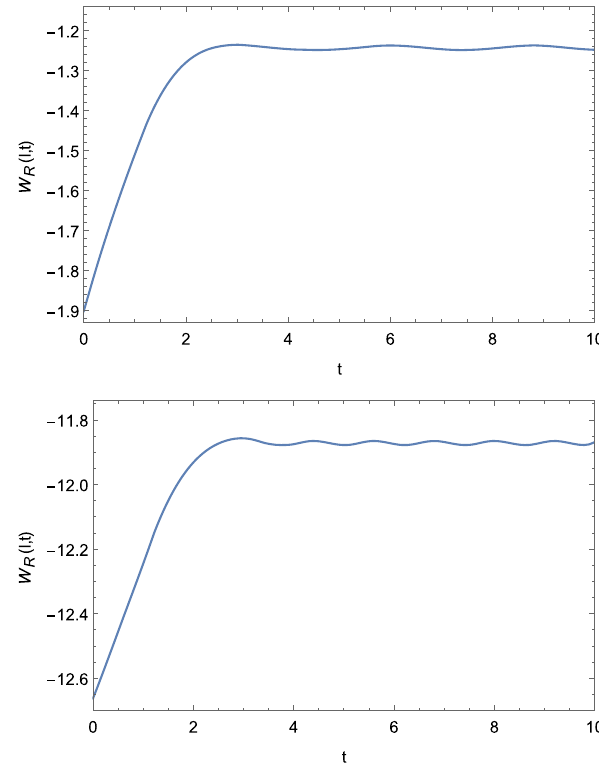
l = 1. The static potential is V ( l ) = − 0 . 4488 , − 1 . 2422 , − 4 . 1120 and − 11 . 8713 corresponding to ν = 1 , 2 , 3 and 4, = 0 . 159, and f